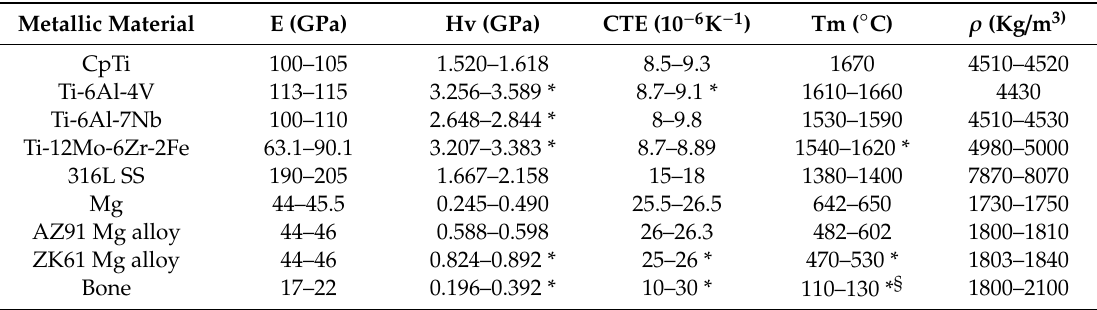
Table1. Di ff erentmetallicmaterialsandtheirmechanical, thermalandphysicalpropertiesincomparison to bone. Data from CES EduPack ™